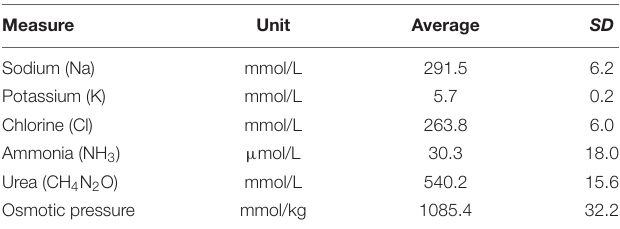
TABLE 1 | Chemical measurements and osmotic pressure of artificial uterine fluid ( n =